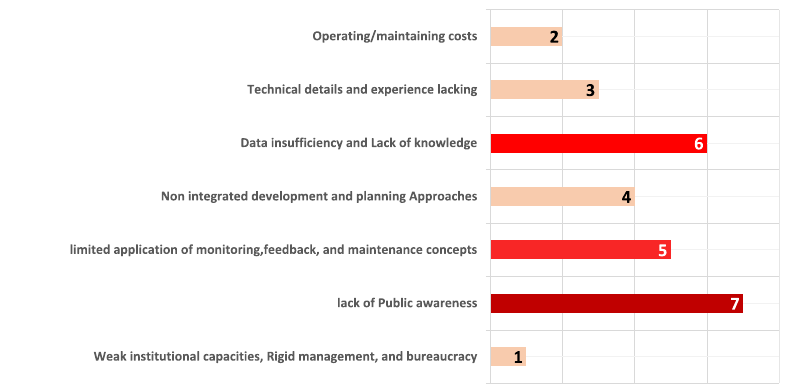
Fig. 10 Urban resilience sufficiency